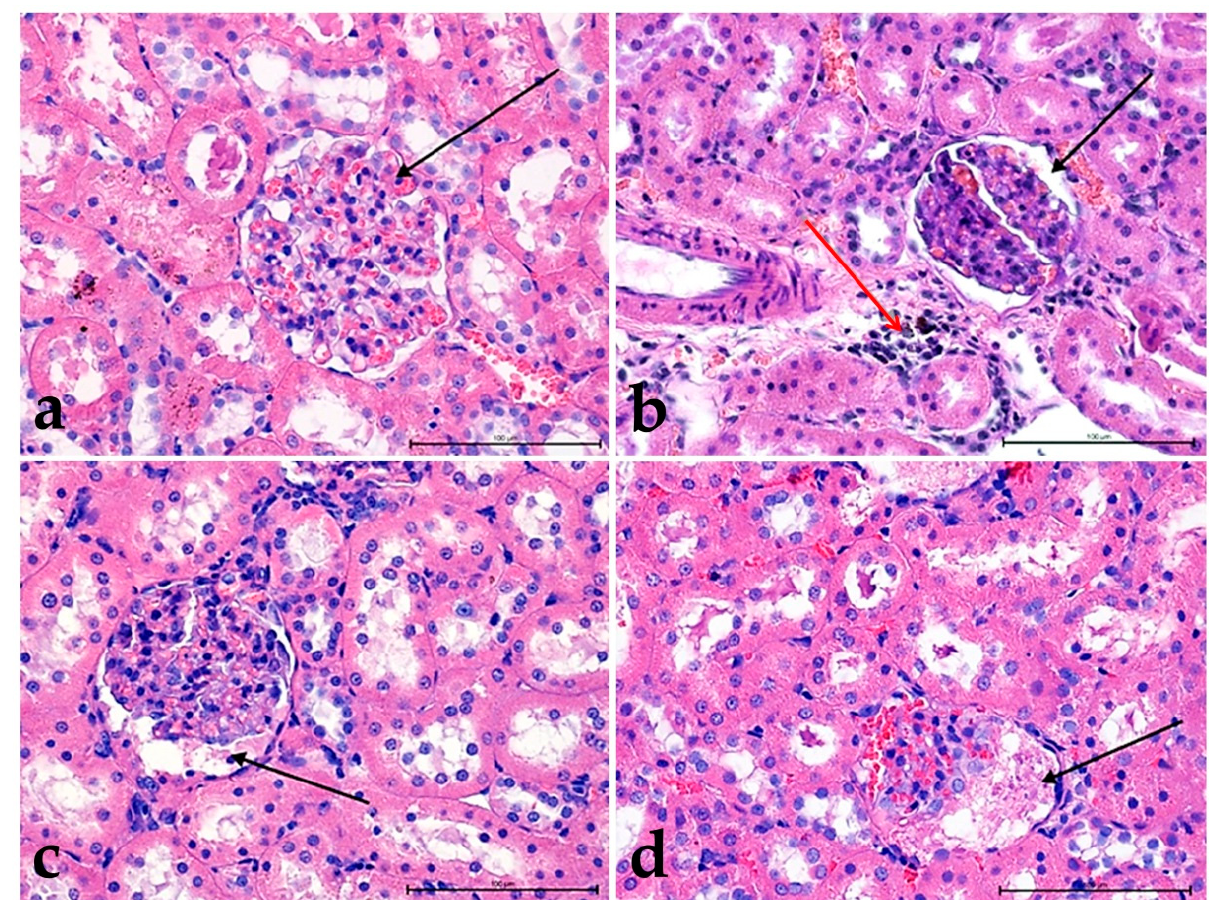
Figure 1. The structure of the kidneys in the control groups: in normal, I ( a ) and high-cholesterol diet, II ( b ); ( a ) note the lack of the urine in proximal tubules and slightly enlarged distal tubules (black arrow); ( b ) glomerulus filled with blood (black arrow) hematoxylin and eosin (H&E) staining. Mag. 400×. Bar scale 100 µm.